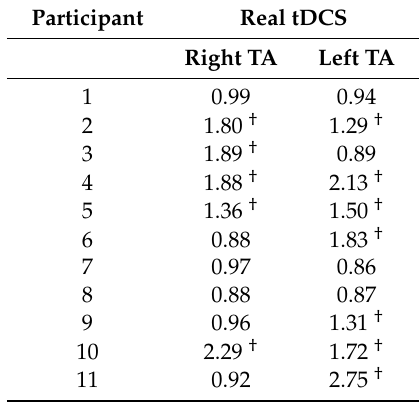
Table 2. Grand average of normalized mean MEP amplitude post real tDCS.